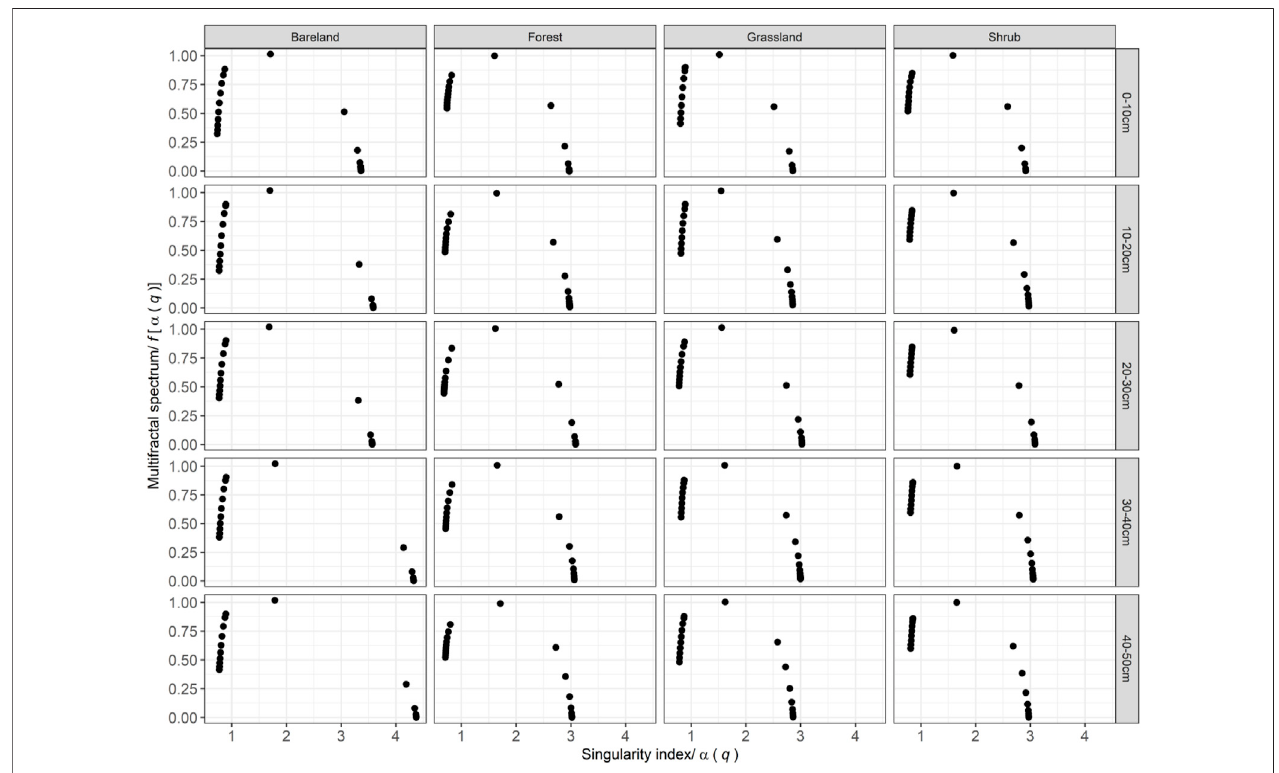
FIGURE 5 | Multifractal spectrum functions of the soil particle-size distribution in different soil layers of four vegetation types in Jiangjiagou Gully.